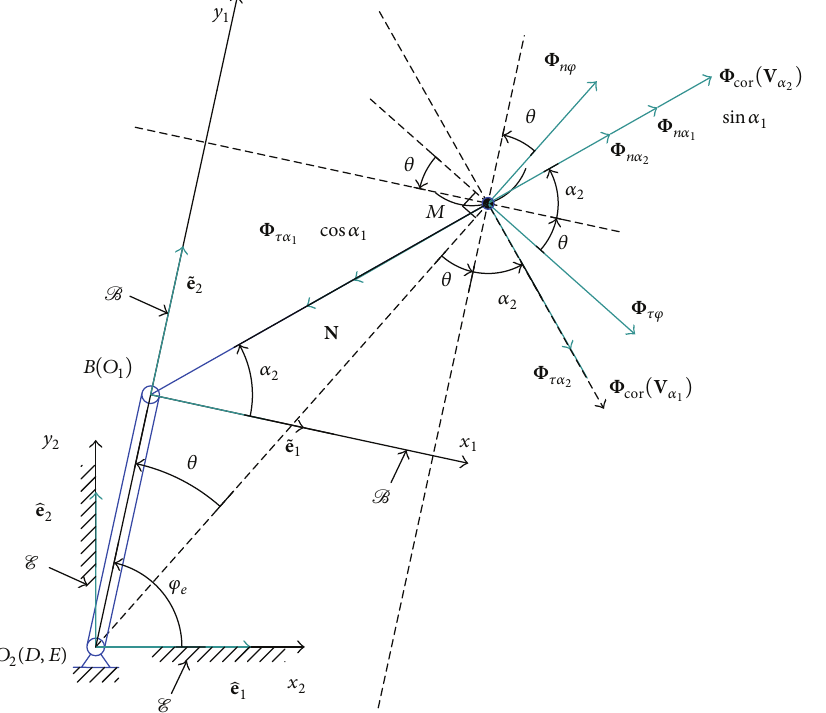
Figure 15: Swaying scheme for dynamic analysis in spherical coordinates of load 𝑀 at the cable 𝑀𝐵 , which is fixedly attached in the point 𝐵 to the crane boom 𝐵𝑂 2 , in the horizontal plane ( 𝑥 1 𝑦 1 ) for nonlinear model derivation in relative spherical